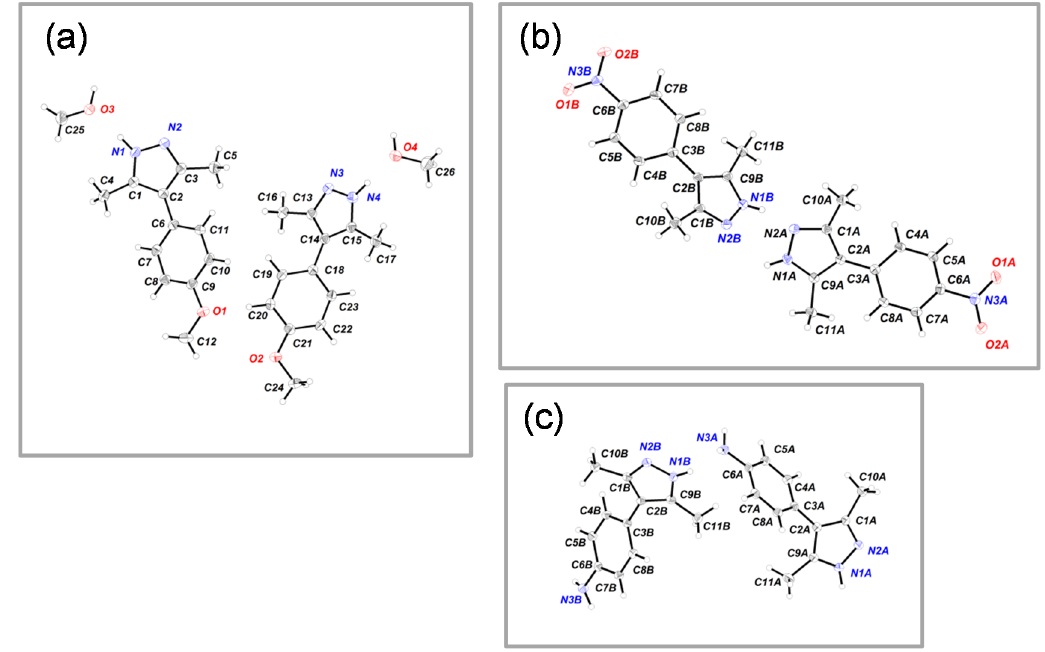
Figure 3. ORTEP diagram (50% probability of displacement ellipsoids) for various structures: ( a ) P1·CH 3 OH ; ( b ) P2 ; ( c ) P3 .